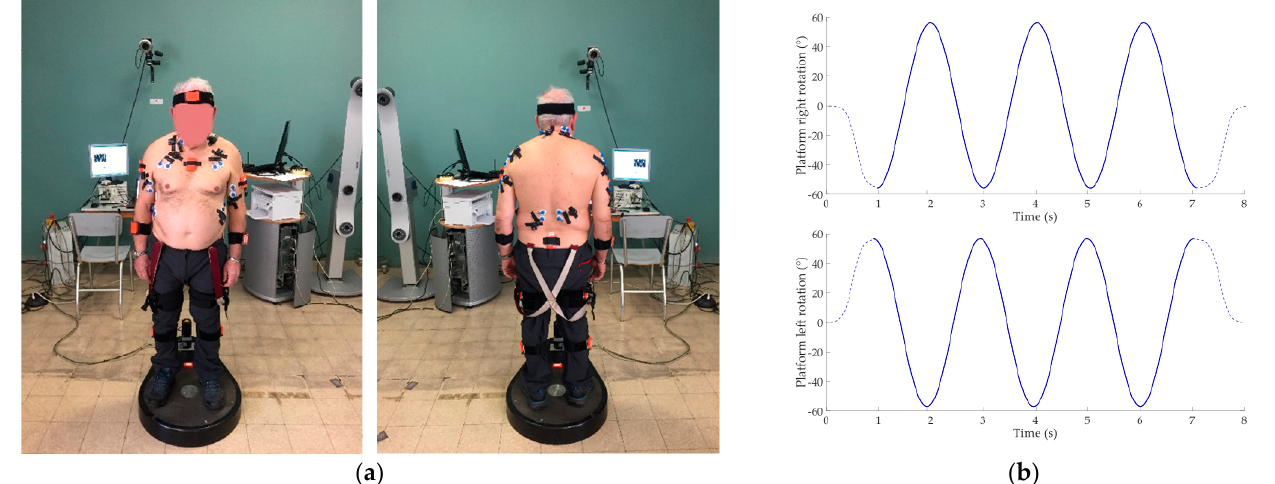
Figure 1. ( a ) Experimental setup and sensor placement on subject; ( b ) Right and left sinusoidal trajectories provided through the Rotobit 1D during the low perturbation condition. Dashed lines represent the sigmoidal trajectory of the beginning and the end of the acquisition. Continuous line represents the sinusoidal